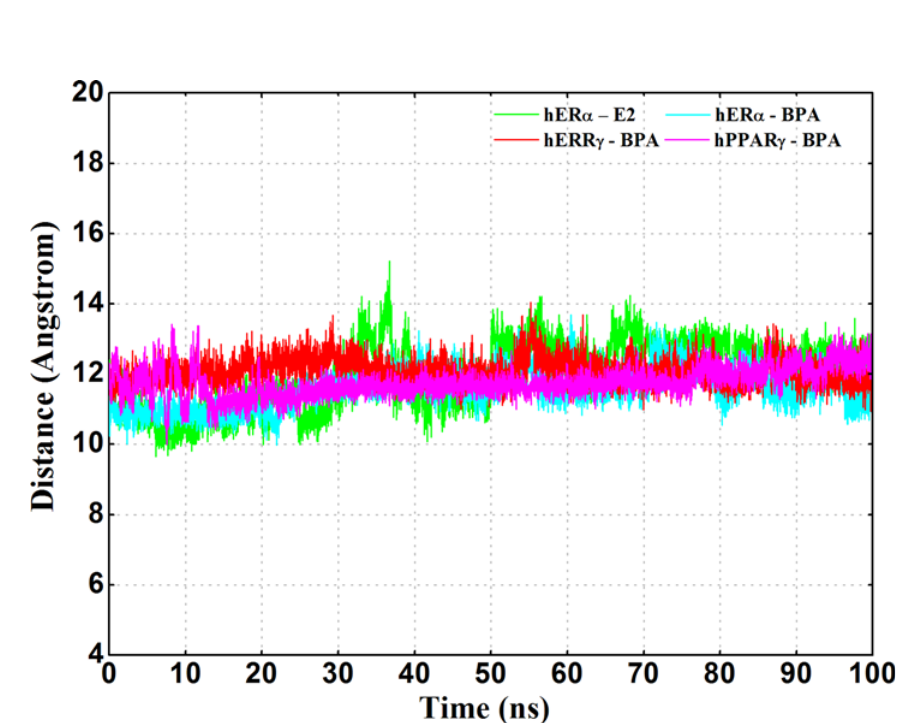
Fig 6. The distances between H11 and H12 of the four systems throughout the 100 ns molecular dynamics simulations.